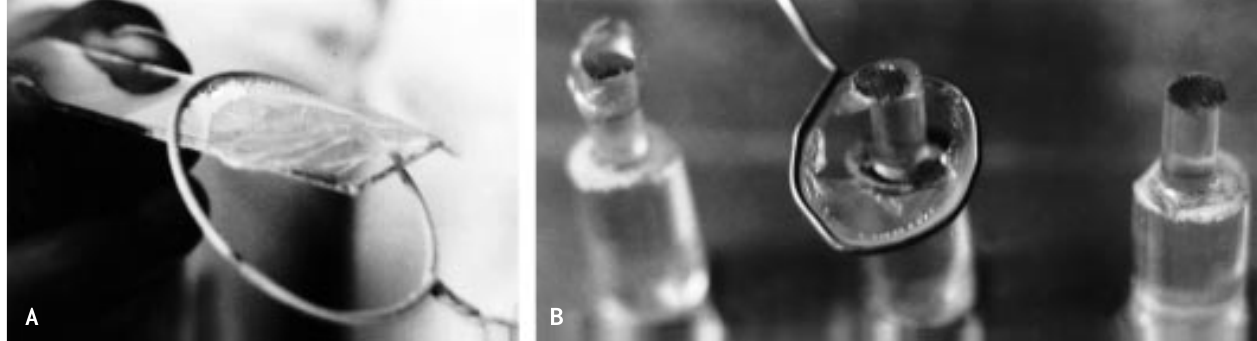
Figure 6 - Photographs showing the special procedure for preparing LMRAG and EMRAG by the dry-mounting method. A, A large wire loop, 2.5 cm in diameter for LM, is dipped into the melted emulsion and air-dried for a few minutes and the dry film is applied to glass slides carrying sections. B, A small wire loop, 1 cm in diameter for EM, is dipped into the melted emulsion and air-dried for a few minutes and the dry film is applied to the mesh on the grid